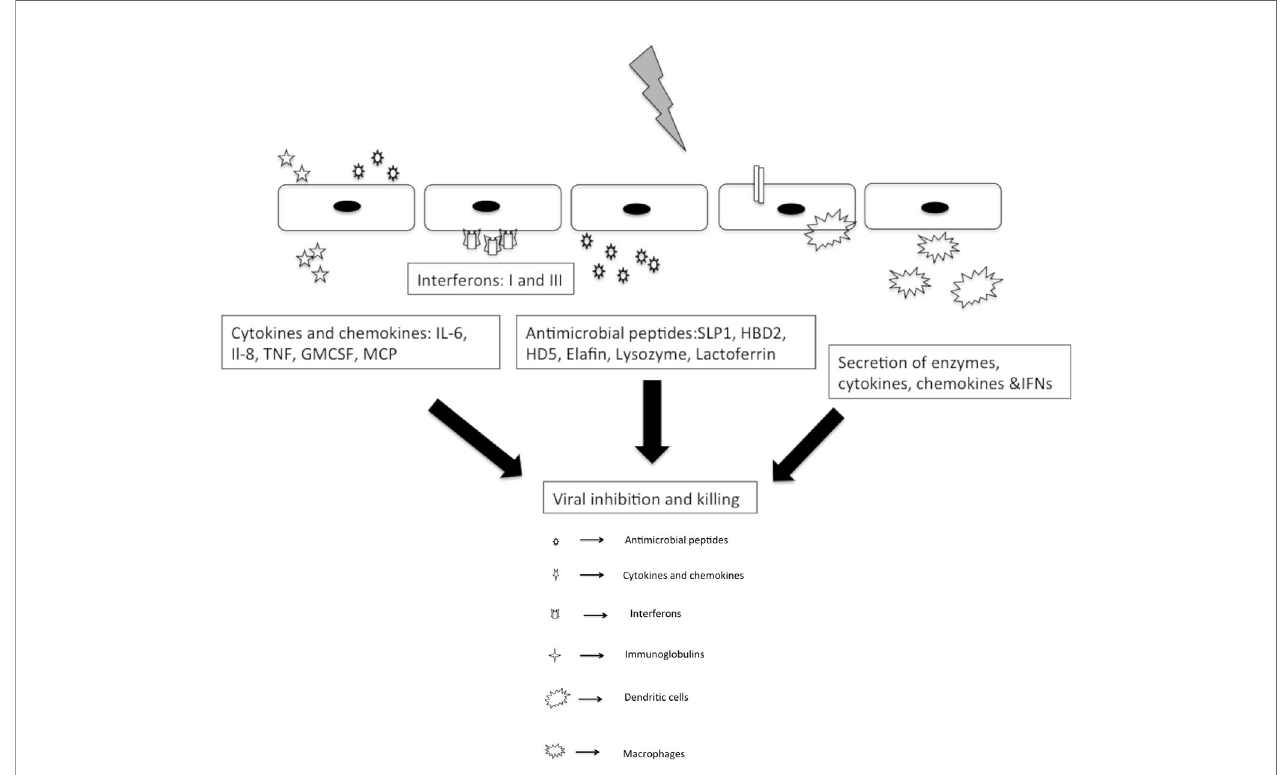
FIGURE 2 | Innate responses to sexually transmitted viral